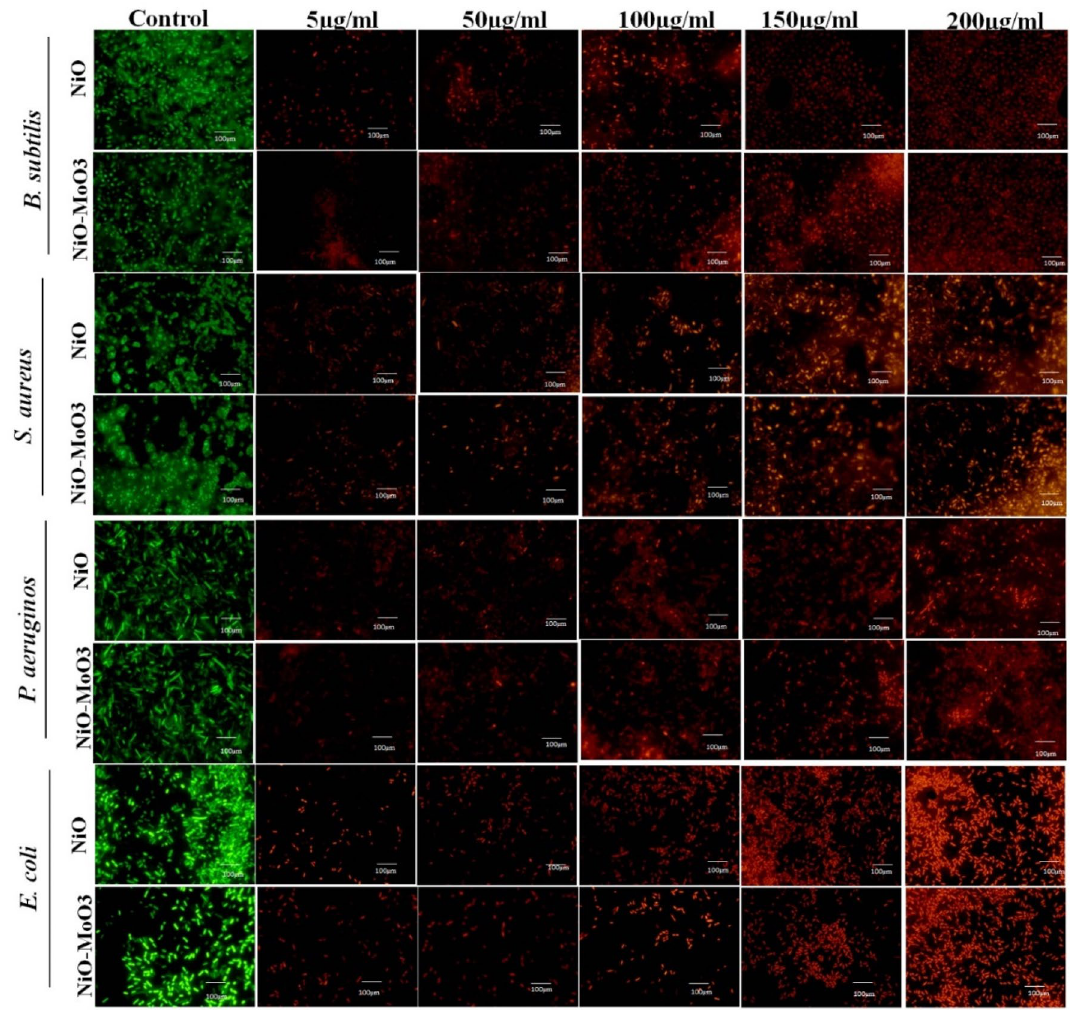
Figure 11. Fluorescence images depicts the live (green colour) and dead (red colour) bacterial cells B. subtilis , S. aureus gram-positive P. aeruginosa , and E. coli